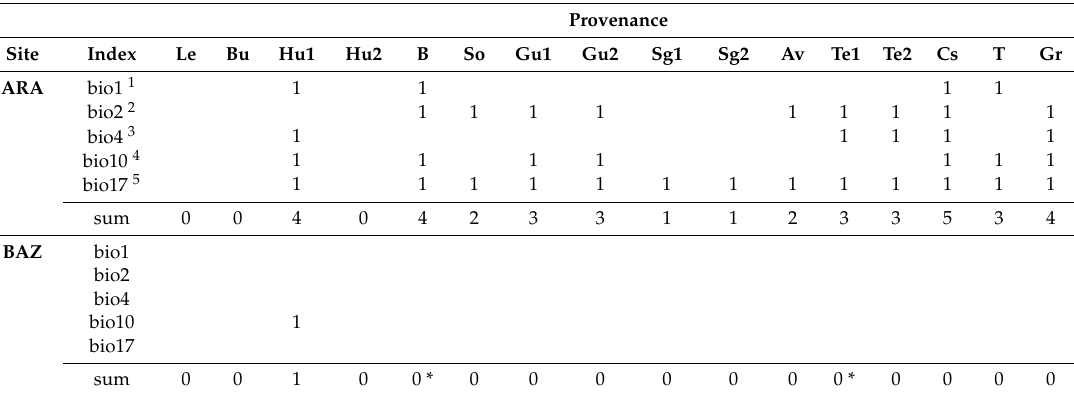
Figure A2. Smooth fits of bio1 (MAT) annual raw values from B4EST-DT for the period 1900–2098 for all provenances and test sites. Table A3. Provenances matching the future scenario (2050) for each site. Asterisks indicate provenances not included in the trial site, but are included here for easier comparisons among sites.